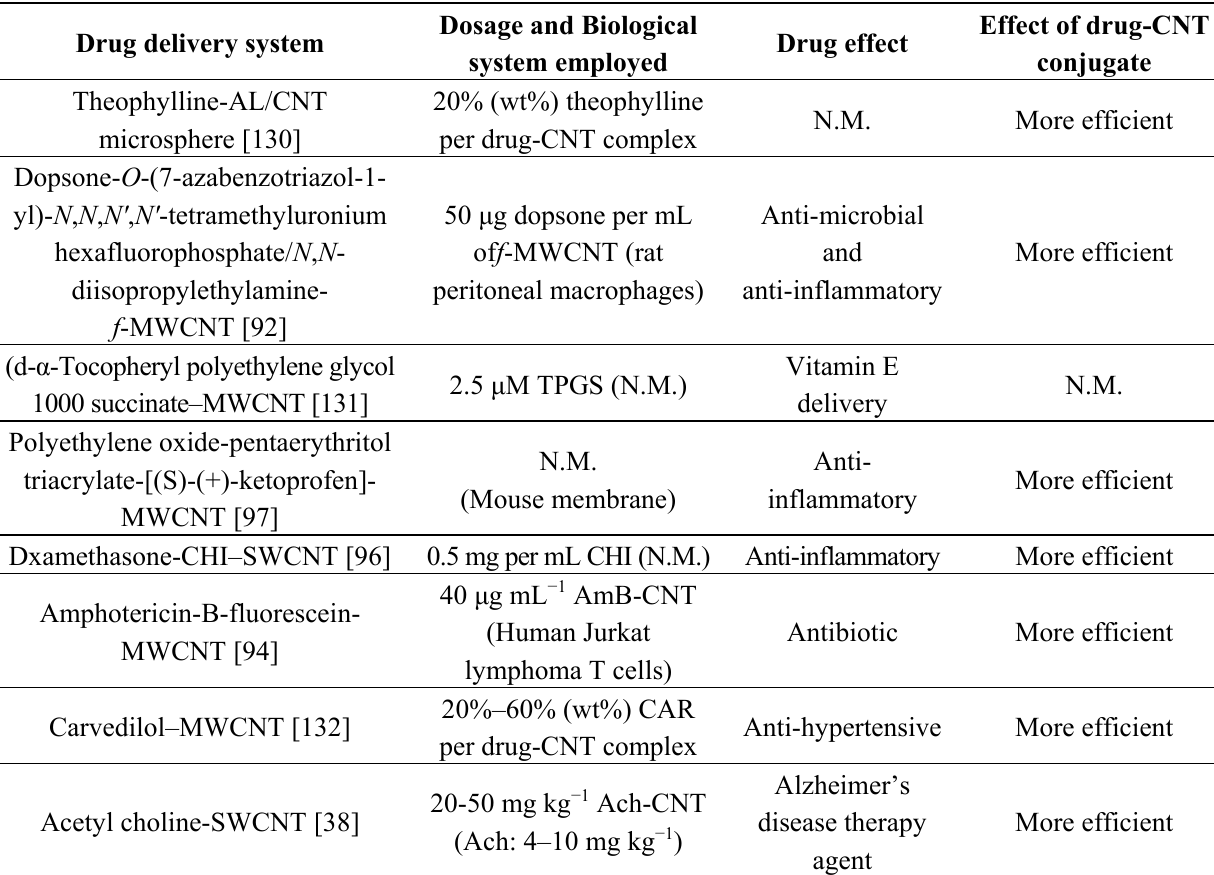
Table 4. Delivery of other drugs through carbon nanotropes